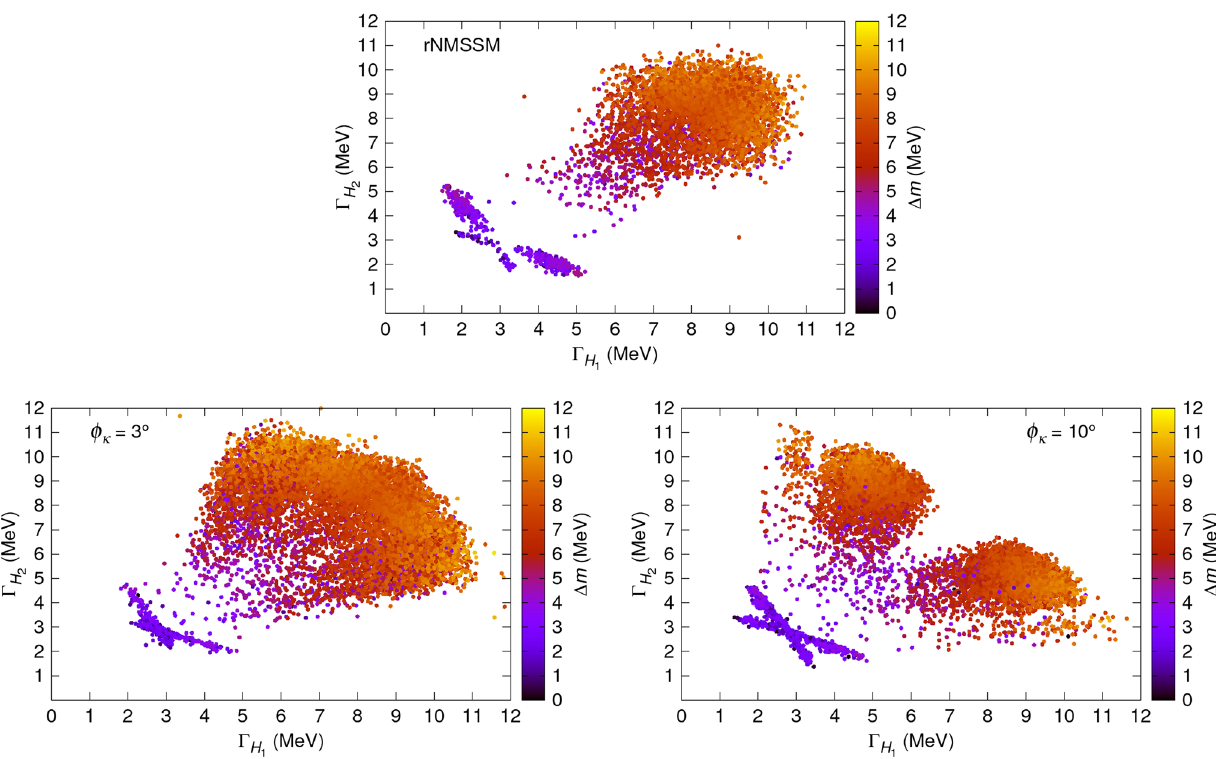
Fig. 2 Points obtained from the parameter scans of the rNMSSM ( top ) and of the cNMSSM with φ κ = 3 ◦ ( bottom left ) and with φ κ = 10 ◦ ( bottom right ). For all the points shown, (cid:7) m ( colour map ) is always smaller than (cid:15) H